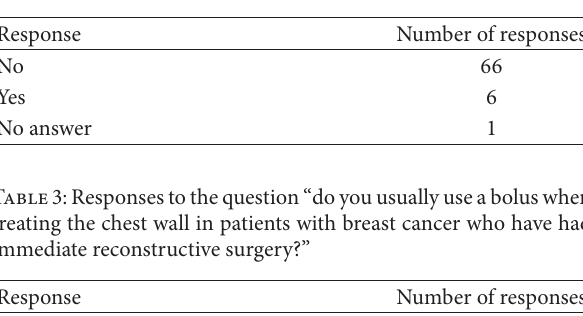
Table 2: Responses to the question “does the type of reconstruction influence your decision regarding choice of fractionation?”